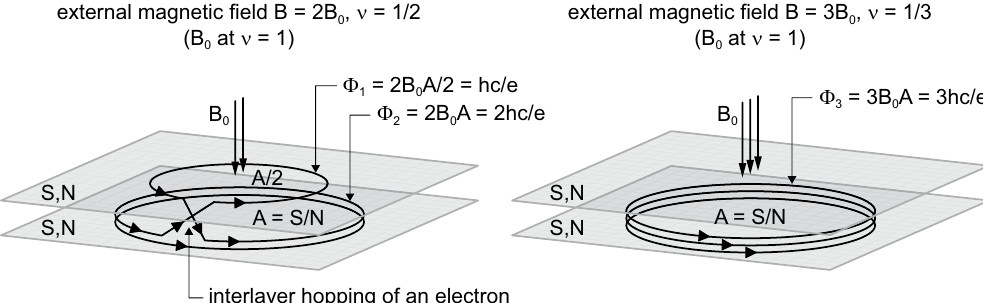
Figure 2. In the bilayer system, there are two possible topologically non-equivalent types of three-loop cyclotron trajectories (corresponding to particle exchange along the braid generator with one additional loop, 3 , built from half of the 3-loop cyclotron orbits 22 ). In the left panel, the three-loop orbit is distributed between σ j two sheets—both sheets contribute their own magnetic fluxes, in contrast to the case when the three-loop orbit is located in a single sheet (right panel). This leads to the different commensurabilities in the following two situations. If loops are distributed between both layers, only two loops participate in the increasing of the orbit size, which gives the commensurability condition